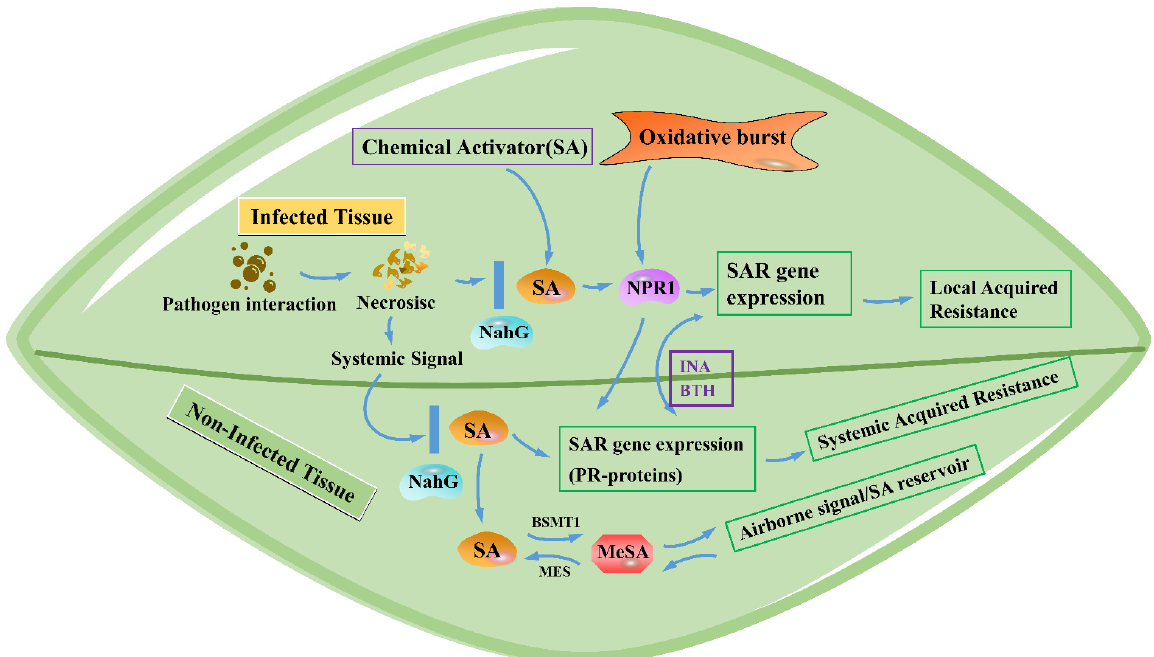
Figure 3. The function of SA in the formation of local resistance and SAR. Plants can accumulate a large amount of SA after being infected by many pathogens. In addition to the SA accumulated at the infection site, SA is also associated with the SAR of uninfected tissues. NPR1 is critical for SA- dependent PR gene expression and SAR. The inhibition of SA accumulation or biosynthesis will inhibit the formation of SAR. NahG is an inhibitor of SA synthesis, which can convert SA into inac- tive catechol. Therefore, the overexpression of this gene can inhibit SAR formation and PR gene expressions. INA and BTH are analogues of SA, which are also plant defense activators and can induce SAR and the expression of PR genes. MeSA is a derivative of SA, which can act as a mobile inducer of SAR and induce the expression of defense genes in adjacent plants. SAR, systemic ac- quired resistance; MeSA, methyl salicylate; BTH, benzothiadiazole; INA, 2,6-dichloroisonicotinic acid; NahG, salicylate hydroxylase; BSMT1, benzoic acid/salicylic acid carboxyl methyltransferases; MES, methylesterases.